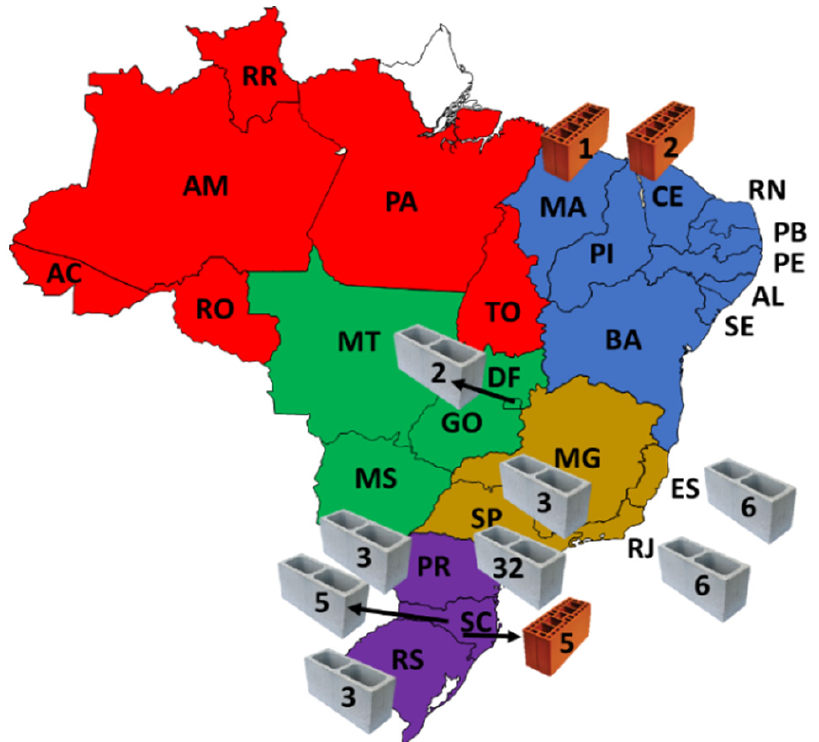
Figure 2. Brazilian map with the structural concrete and ceramic block factories. Red—northern region. Blue—northeastern region. Green—central-western region. Yellow—southeastern region. Purple—southern region.